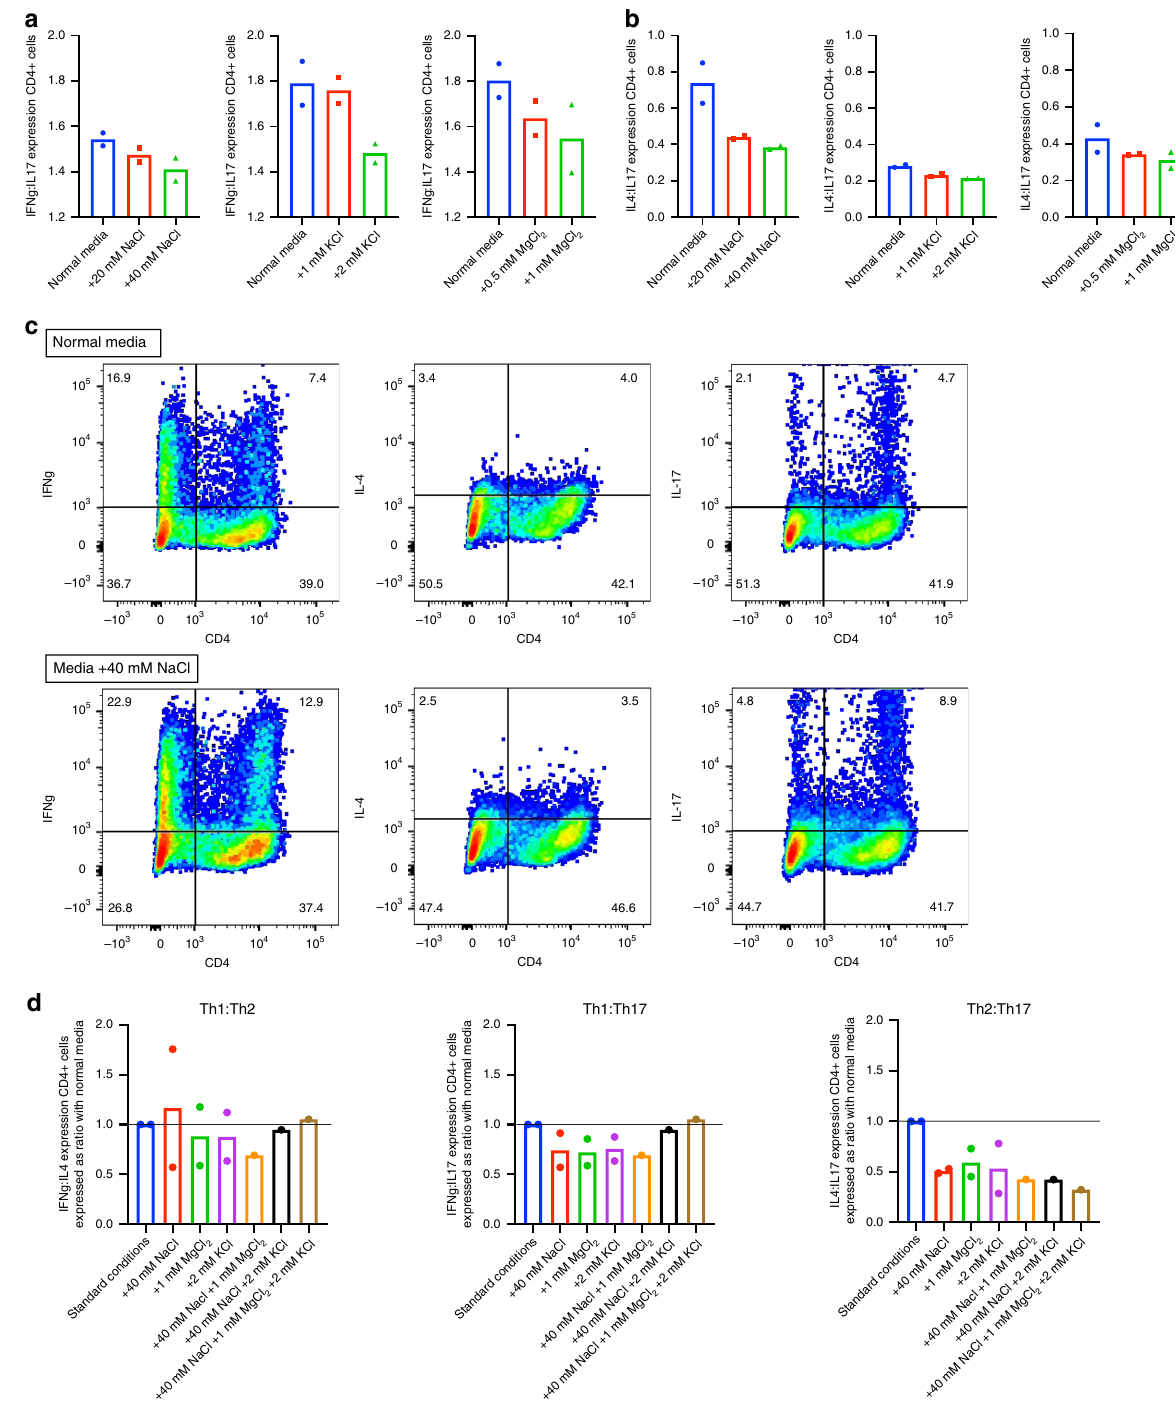
Fig. 6 Effect of altering extracellular ion concentration within a physiological range on CD4 subset balance. a Effect of NaCl (0 – 40 mM), KCl (0 – 2 mM), and MgCl 2 (0 – 0.8 mM) during T-cell activation with anti-CD3/anti-CD28 on the ratio of expression of IFN γ :IL-17 in CD4 + cells, representative of Th1:Th17 cells. Data shown represent dose – response in a healthy control. Mean of technical duplicates is plotted. b Effect of NaCl (0 – 40 mM), KCl (0 – 2 mM), and MgCl 2 (0 – 0.8 mM) during T-cell activation with anti-CD3/anti-CD28 on the ratio of expression of IL-4:IL-17 in CD4 + cells, representative of Th2:Th17 cells. Data shown represent dose – response in a healthy control. Mean of technical duplicates is plotted. c Representative FACS dot plots of the effect of + 40 mM NaCl on the expression of IFN γ , IL-4, and IL-17 in CD4 + cells from a healthy control. Cell proportions as percentages are documented within each quadrant. d CD4 + subset balance after T-cell activation with anti-CD3/anti-CD28 in the presence of NaCl (40 mM), KCl (2 mM), and MgCl 2 (1 mM) used alone and in combination. Data show subset balance reported as a ratio to standard conditions in healthy controls ( n = 2). The median ratio is plotted. Lines drawn at a ratio of 1 represents no difference in subset balance in the presence of ions compared to standard conditions. Source data are provided as a Source data fi